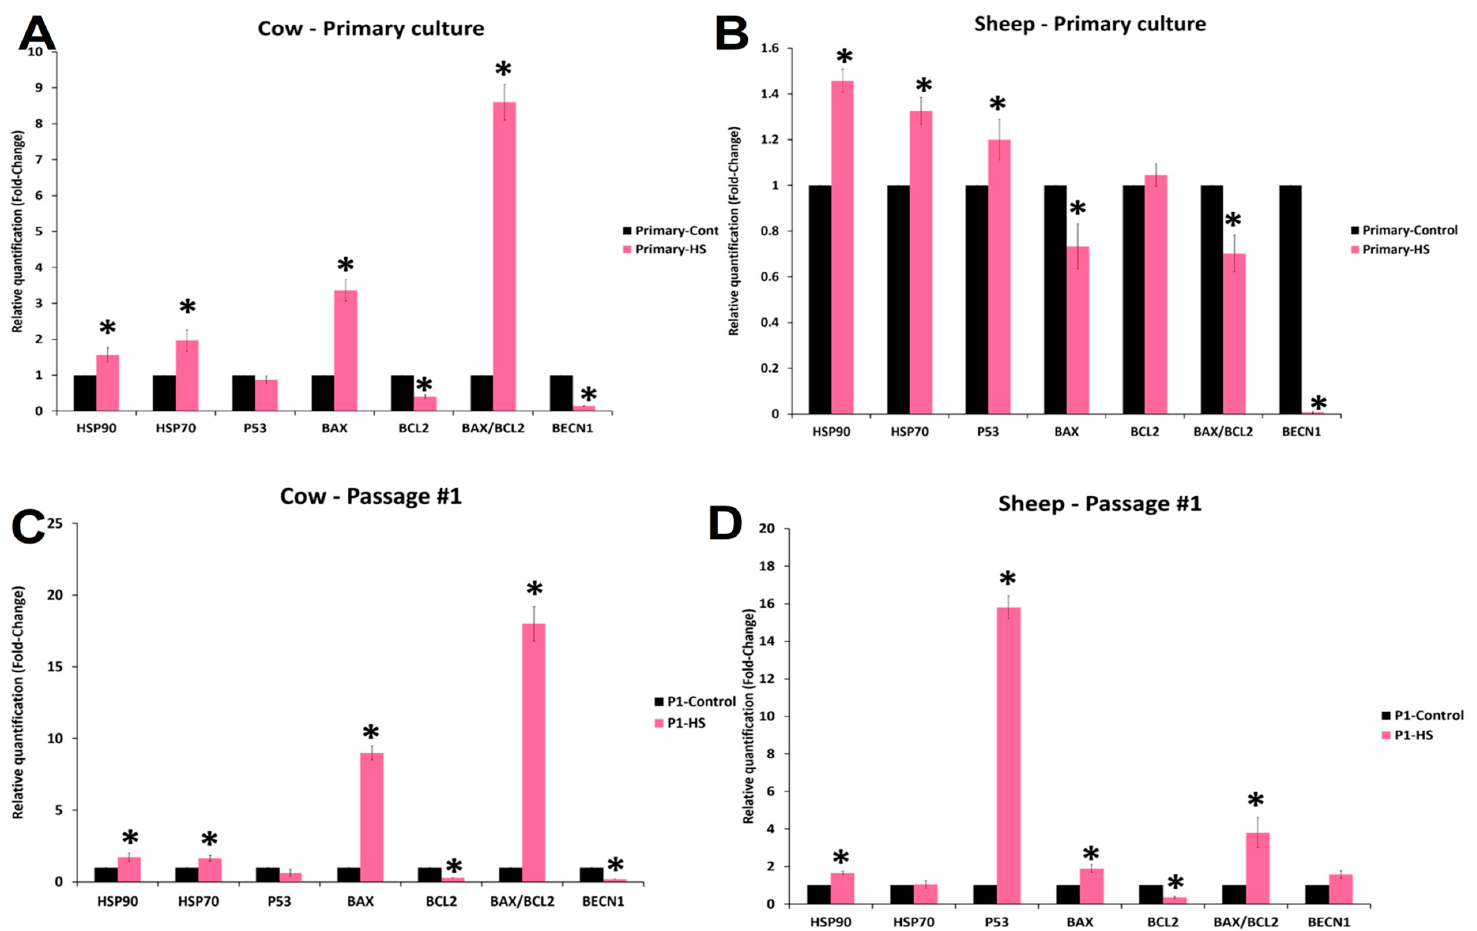
Figure 9. Relative quantitative PCR and fold change of selected mRNA transcript expressions in cow and sheep fibroblasts of different passages exposed to acute heat shock (45 °C for 4 h). ( A and B) show the primary cultured fibroblasts in cows and sheep, respectively; ( C and D) show the first passage (P1) fibroblasts in cows and sheep, respectively. Data are presented as means ± SEM, values of the same mRNA transcript in control and heat-shocked cells were analyzed using Student’s t -test, and asterisks (*) indicate significant differences at p < 0.05.